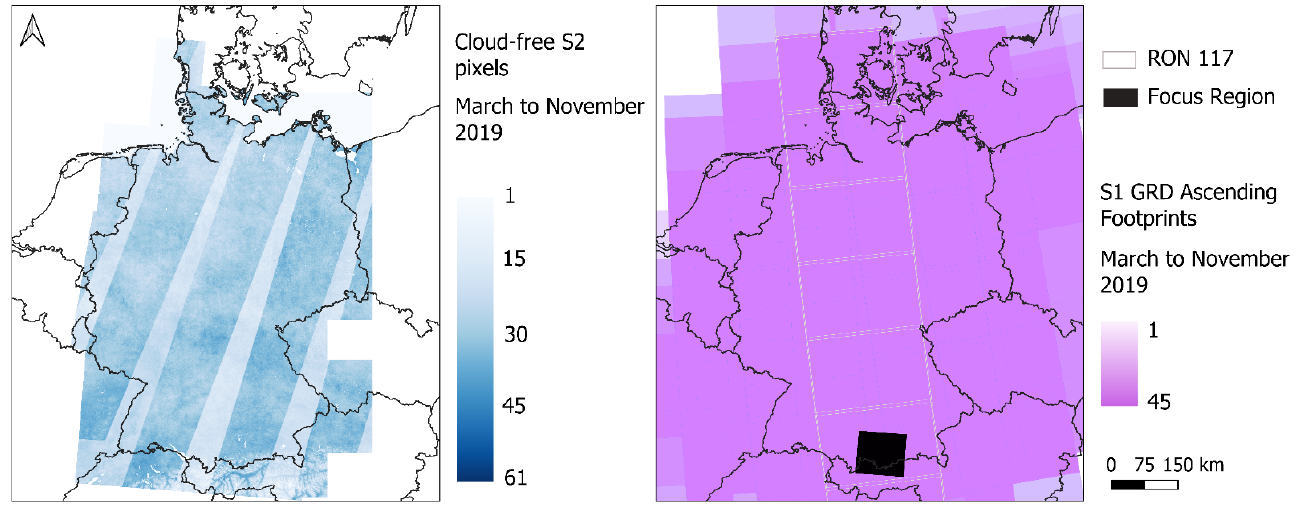
Figure 2. Data coverage of S2 after cloud screening and S1 for the period: 1 March 2019 to 30 November 2019 cropped to Germany, highlighting the inhomogeneity in data distribution due to overlapping orbits and varying cloud coverage of S2.